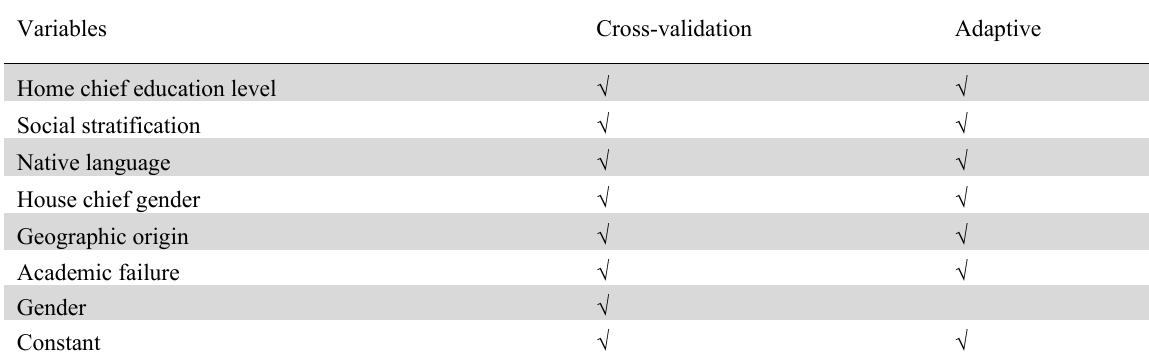
Selected variables Variables